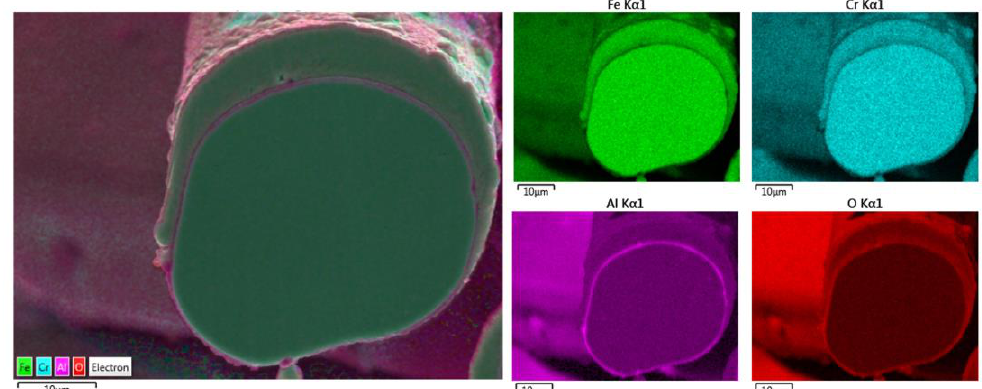
Figure 11. Elemental EDS mapping of Fe, Cr, Al, and O of a 17 μ m FeCrAl fiber after one MSHT cycle.